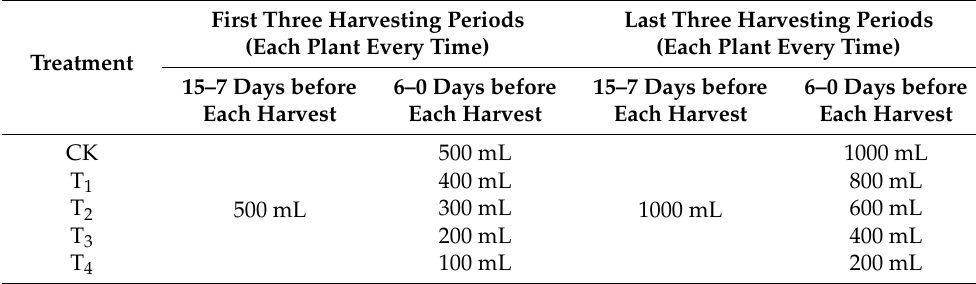
Table 1. Experimental factors and corresponding